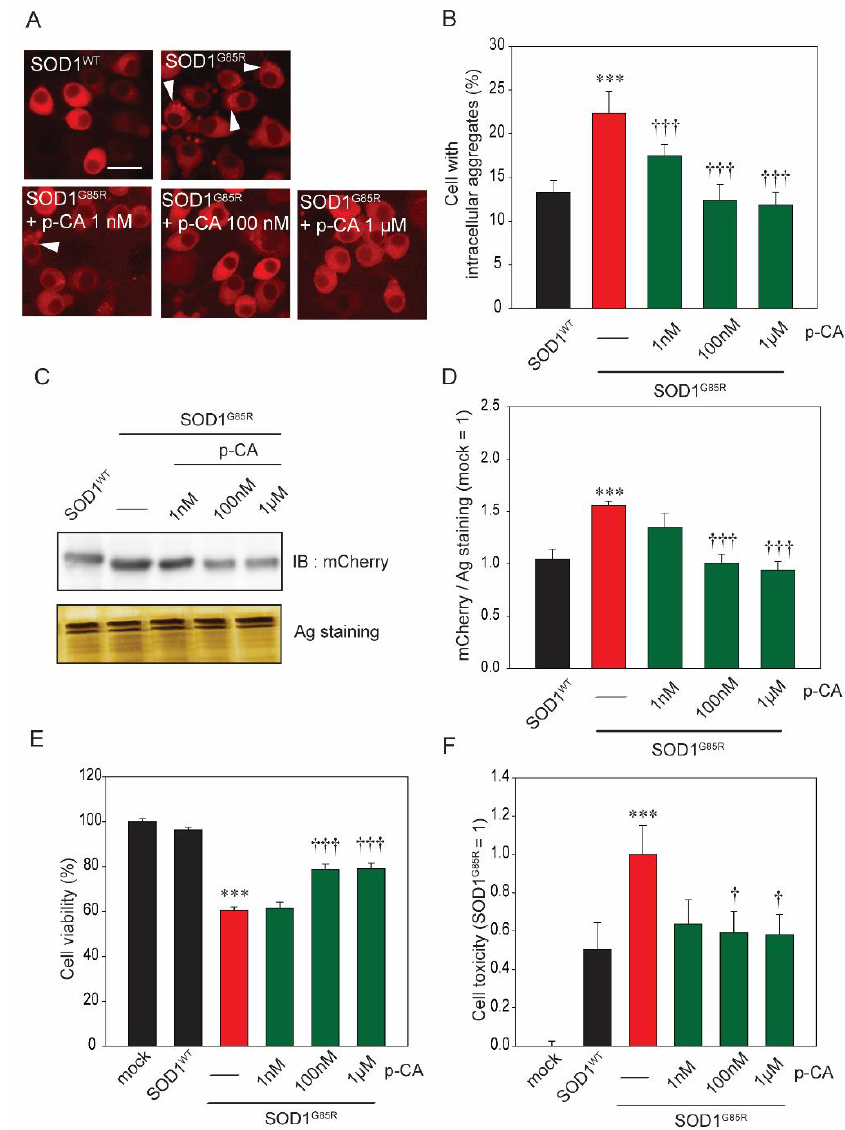
Figure 1. p-Coumaric acid (p-CA) reduced subcellular aggregation of mutant copper – zinc superoxide dismutase 1 (SOD1 mut ) and protected against SOD1 mut -induced neurotoxicity. ( A ) Imaging of cytoplasmic mCherry–SOD1 aggregates (white arrowheads) in the presence or absence of p-CA in N2a cells. ( B ) Quantified analysis of imaging. ( C ) Immunoblot analysis of mCherry with a 1% Triton X-100 insoluble fraction. (D) Densitometric quantification of mCherry. ( E ) Cell viability was measured by MTT assay. ( F ) Cell toxicity was measured by LDH assay. Differences were evaluated by one-way ANOVA (mean ± SEM, n = 3). *** p < 0.001 vs. SOD1 WT , ††† p < 0.001, † p < 0.05 vs. SOD1 G85R. p-CA: p-coumaric acid. Scale bar: 10 µm.